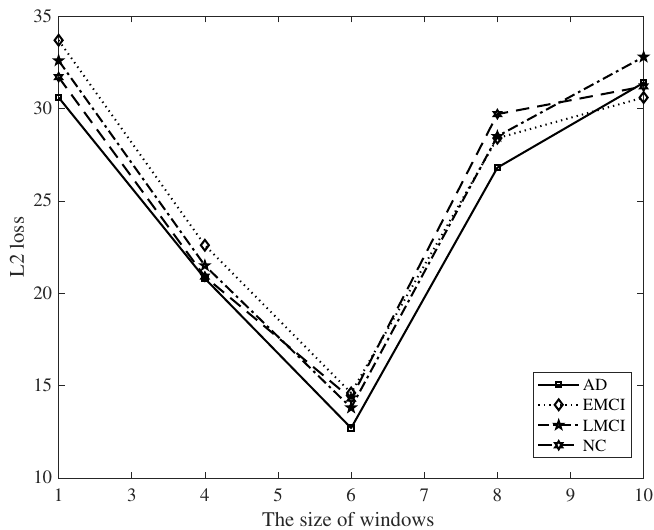
Figure 3. Influence of sliding window on (cid:96) 1 loss.